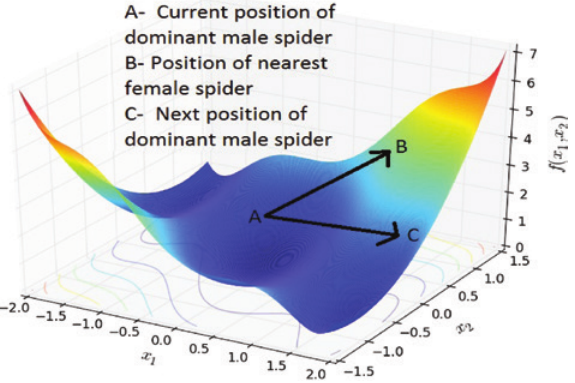
Figure 3: Generation of the Next Position of Dominant Male (Reprinted from